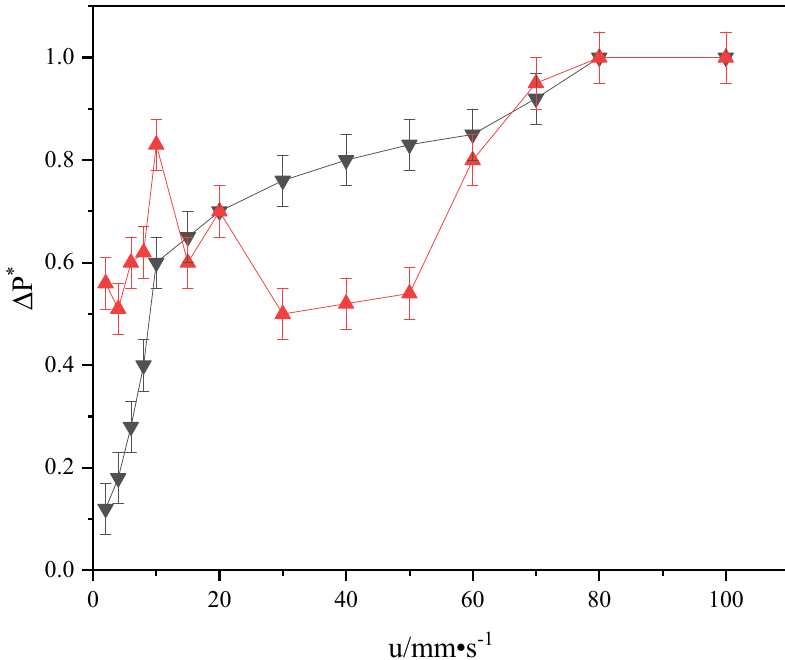
Figure 9. Pressure drop velocity curve of the bed in the silent field.